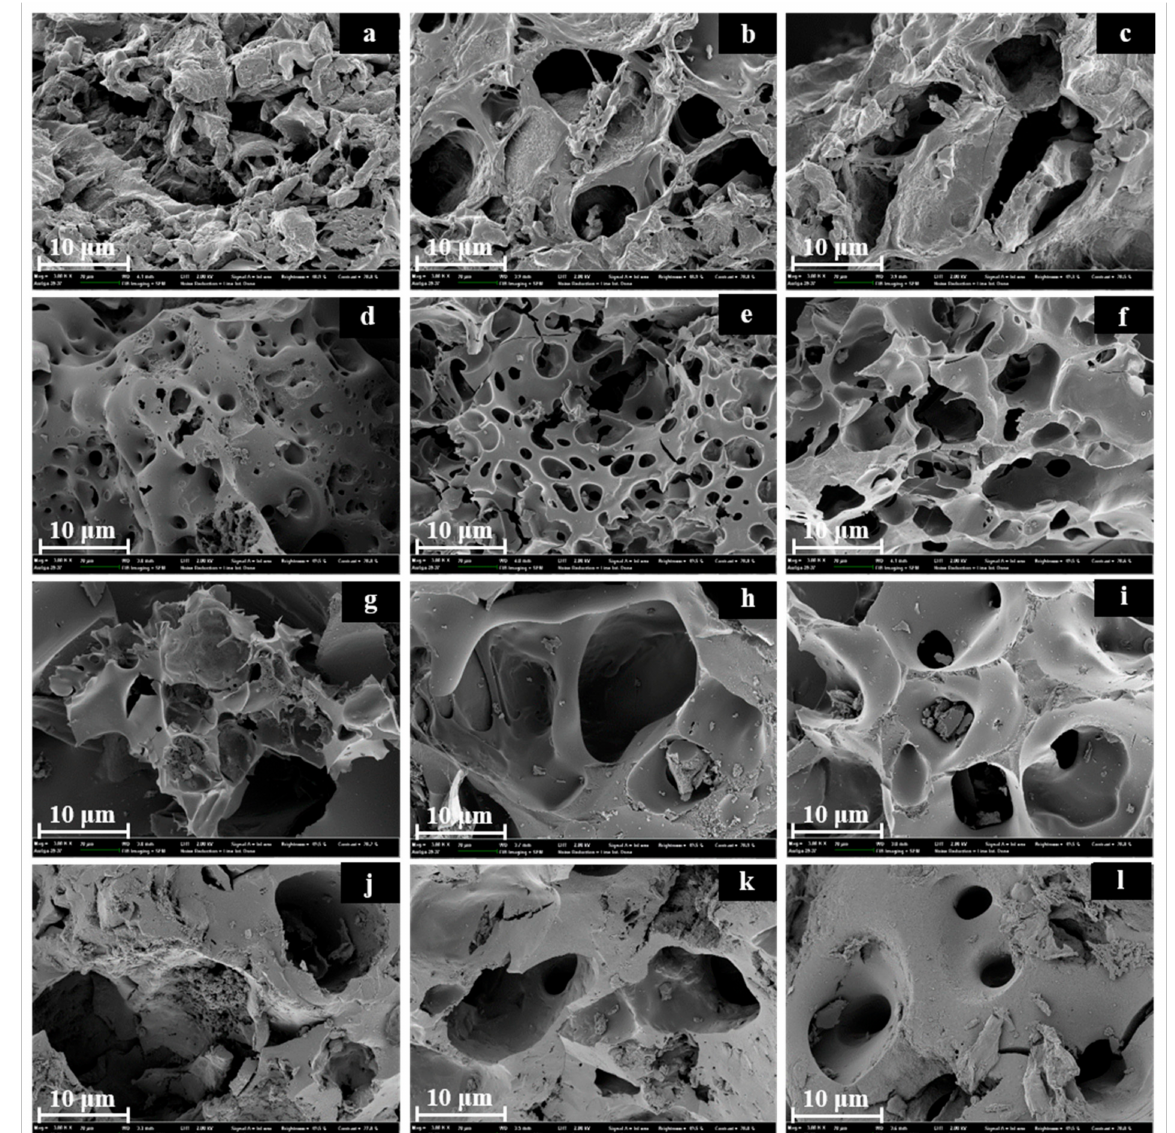
Figure 5. SEM image of coffee waste activated carbon prepared at different temperatures 600 ◦ C, 700 ◦ C and 800 ◦ C. ( a – c ); CWAC, ( d – f ); CWACK, ( g – i ); CWACZ, and ( j – l ); CWACP, respectively (the SEM image of activated carbon prepared using a mixing ratio of activating agent of 1:1 is not included in this